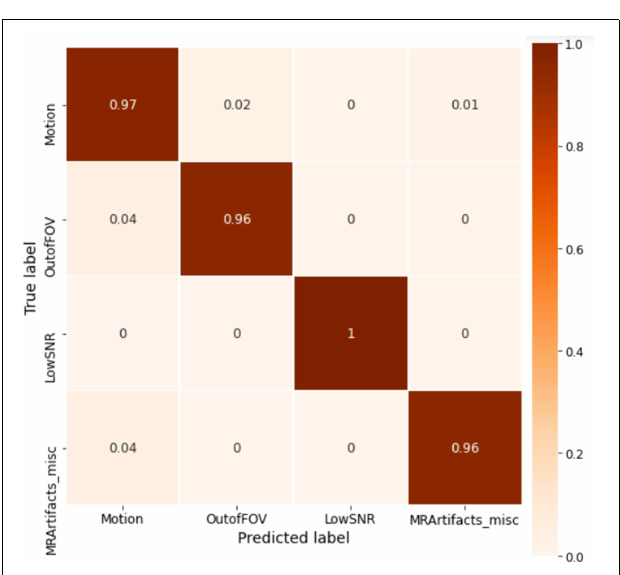
FIGURE 8 | The whole volume-level confusion matrix for the ABCD test set. After utilizing the voting process, the matrix turns more diagonal as the misclassification errors get